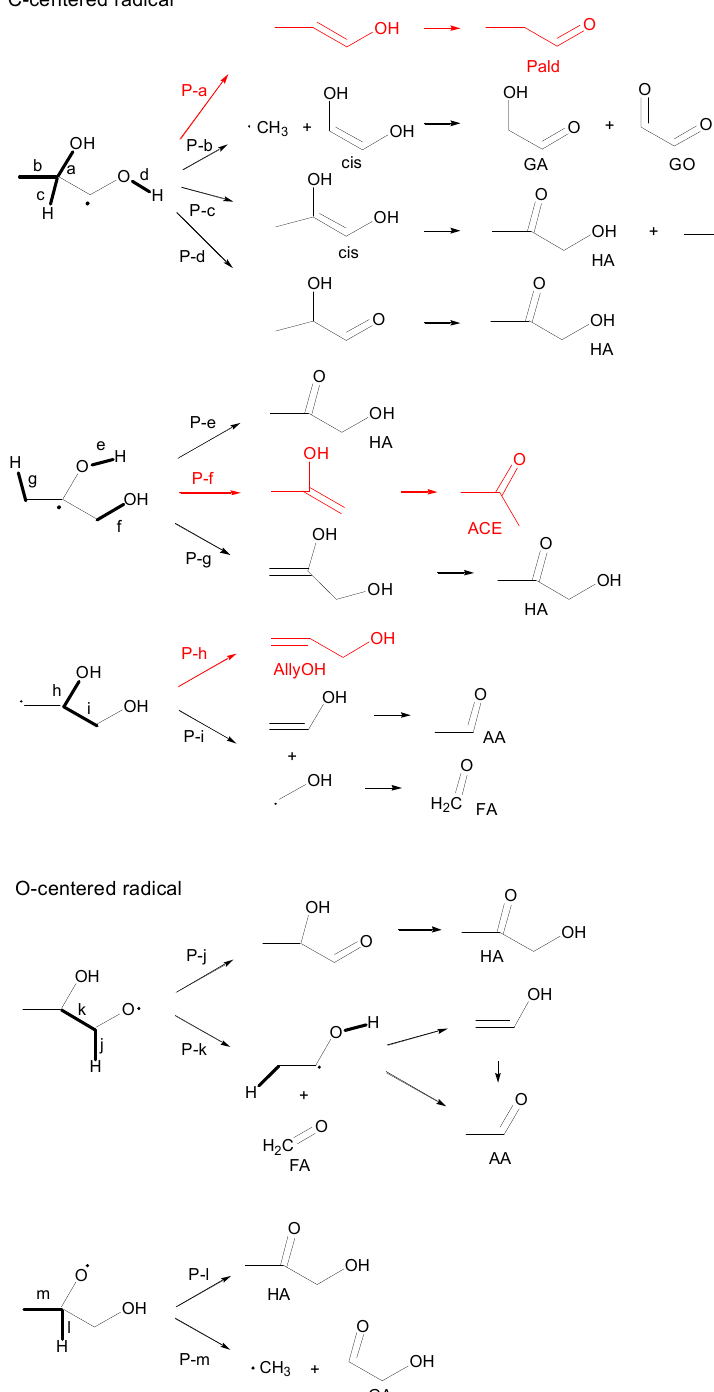
Figure 13. Possible radical chain pathways from the C- and O-centered radicals of propylene glycol (PG). The bond with a bold line, which is located at the β -position to the radical, is expected to be cleaved through a β -scission reaction. Pald, propionaldehyde; AllyOH, allyl alcohol; MeGO, methylglyoxal; HA, hydroxyacetone; ACE, acetone; GA, glycolaldehyde; GO, glyoxal; AA, acetaldehyde; and FA,